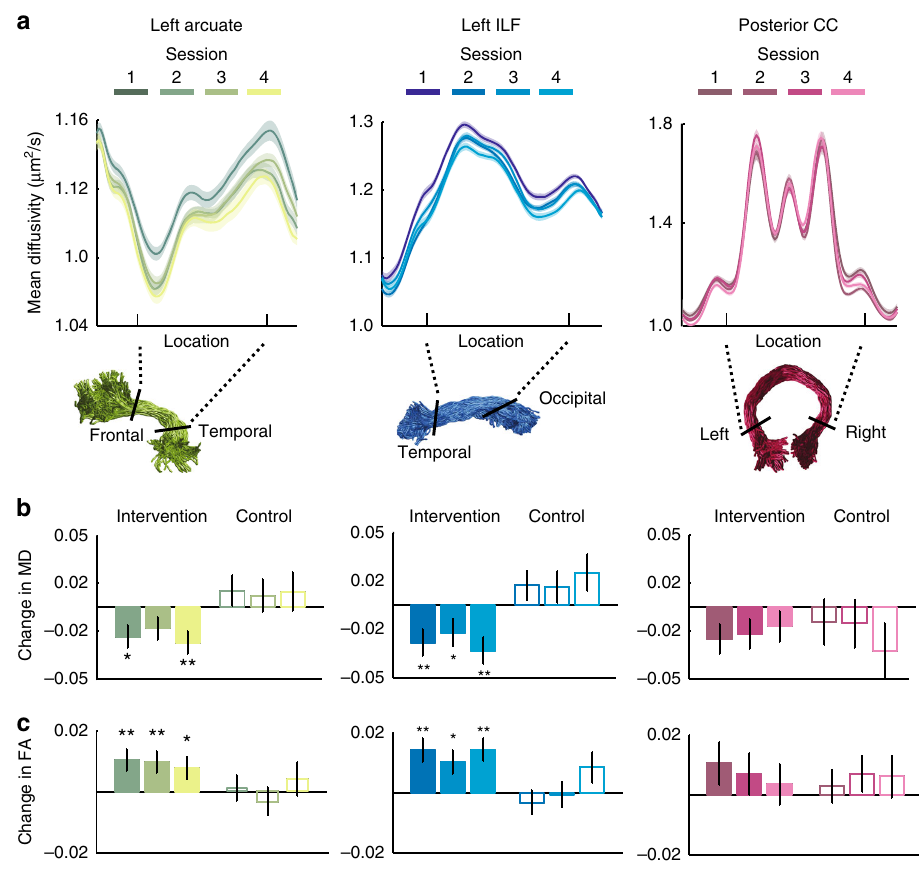
Fig. 2 Change vs. stability in Tract Pro fi les during reading intervention. a Mean diffusivity (MD) values were mapped onto each of the 100 evenly spaced nodes spanning termination points at the gray – white matter boundary to create a ‘ Tract Pro fi le ’ (see Methods and ref. 78 for additional details of this analysis). For visualization purposes, the middle 80 nodes are plotted. Each line represents the group average MD across subjects, measured at four time points: pre-intervention (Session 1), after ~2.5 weeks of intervention (Session 2), after ~5 weeks of intervention (Session 3), and after 8 weeks of intervention (Session 4). Shaded error bars give ±1 standard error of the mean. Color values indicate session, ranging from darkest (Session 1) to brightest (Session 4) for each tract. The x axis shows the location where each tract was clipped prior to analysis (corresponding to black boundary lines in renderings, below). Tract renderings are shown for an example subject. The middle 60% (bounded by black lines) of each tract was analyzed in b , c , to avoid partial volume effects that occur at endpoints of the tract, where it enters cortex. Both the arcuate fasciculus (AF) and inferior longitudinal fasciculus (ILF), but not the posterior callosal connections, show a systematic decrease in MD over the course of intervention. b , c Bars show model-predicted change (coef fi cients and standard errors from mixed effects model) in MD ( b ) and FA ( c ) for each session. Bar heights represent the magnitude of change observed in that session, relative to Session 1 (pre-intervention) baseline, as determined by the mixed effects model. As described in the main text, both the AF and ILF showed signi fi cant change between sessions for the intervention group ( fi lled bars) but not the control group (un fi lled bars). Asterisks indicate a signi fi cant decrease in MD ( b ) or increase in FA ( c ) for each session relative to the pre-intervention baseline at a Bonferroni-corrected * p < 0.05 and ** p <